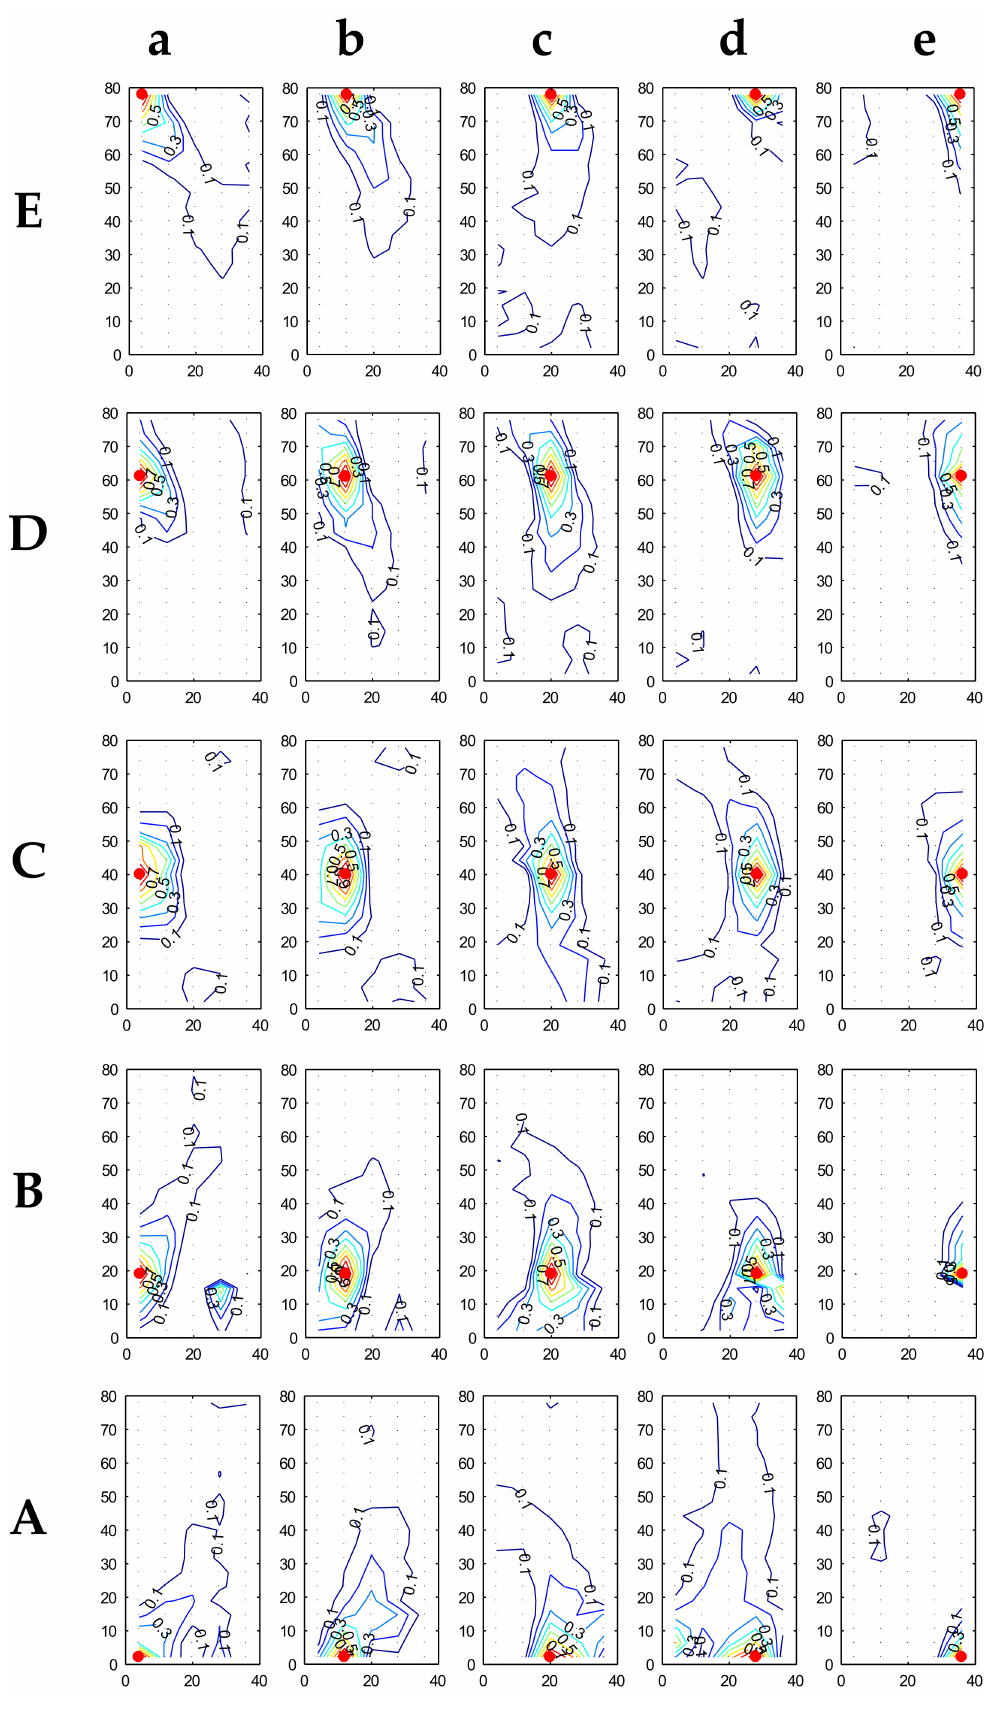
Figure 14. Correlation coefficient trend for RLF at 90 ◦ . Color bar as in Figure